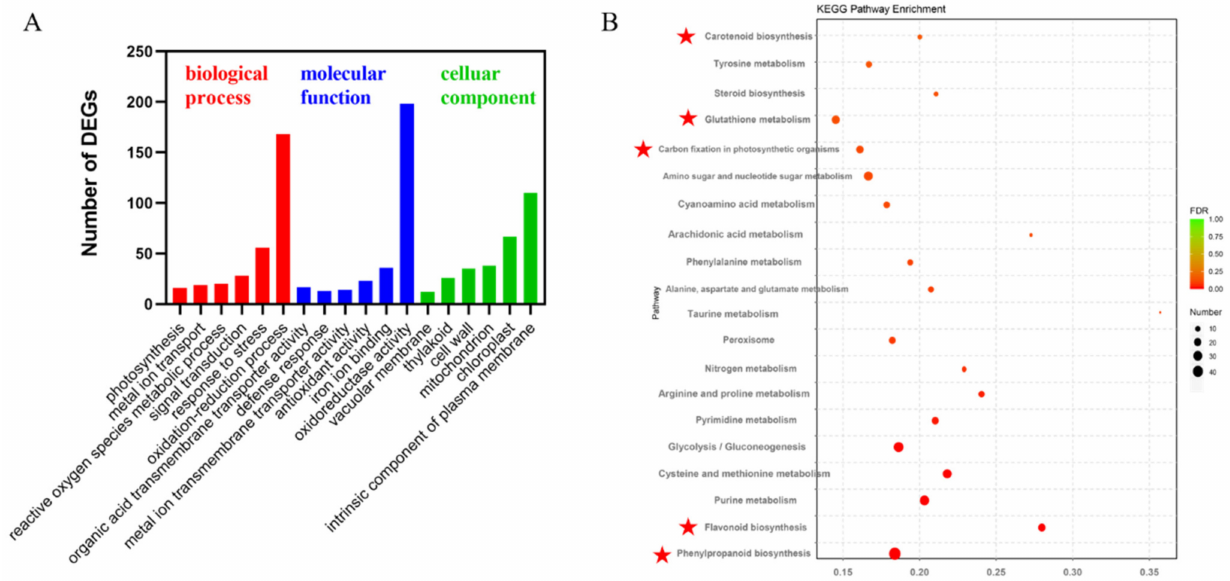
Figure 3. GO ( A ) and KEGG ( B ) analyses of the transcriptional changes of DEGs induced by DFO in C. camphora. The circle colour and size indicate the p -value and gene number,